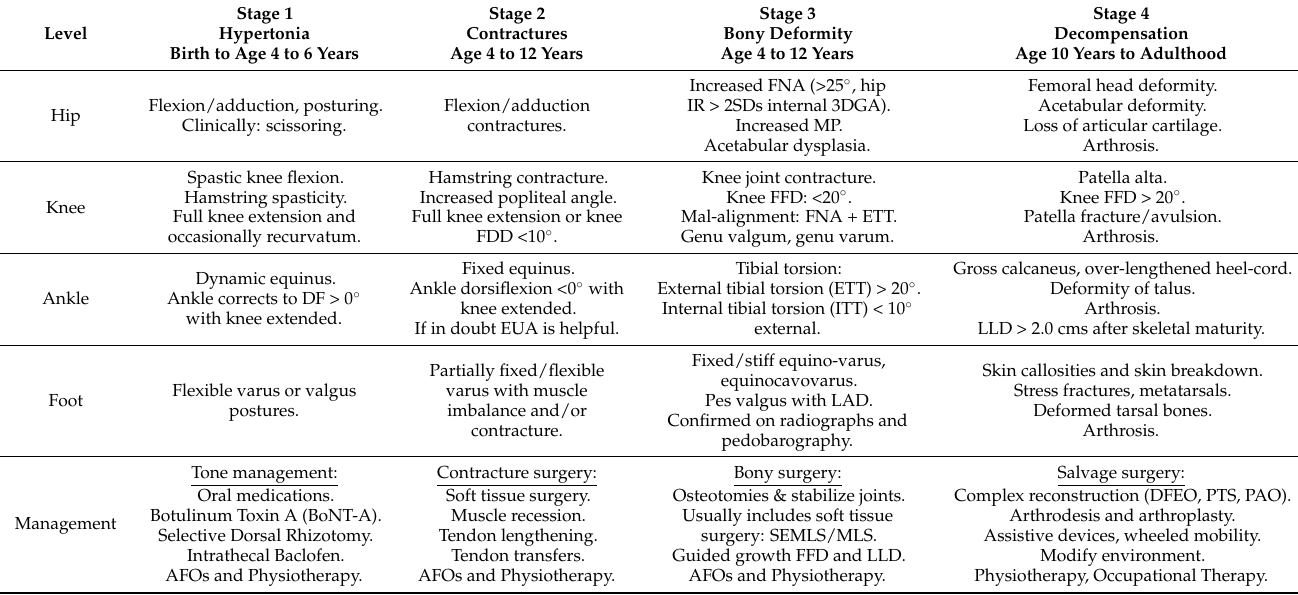
Table 1. Musculoskeletal pathology in children with spastic CP, according to anatomical level.